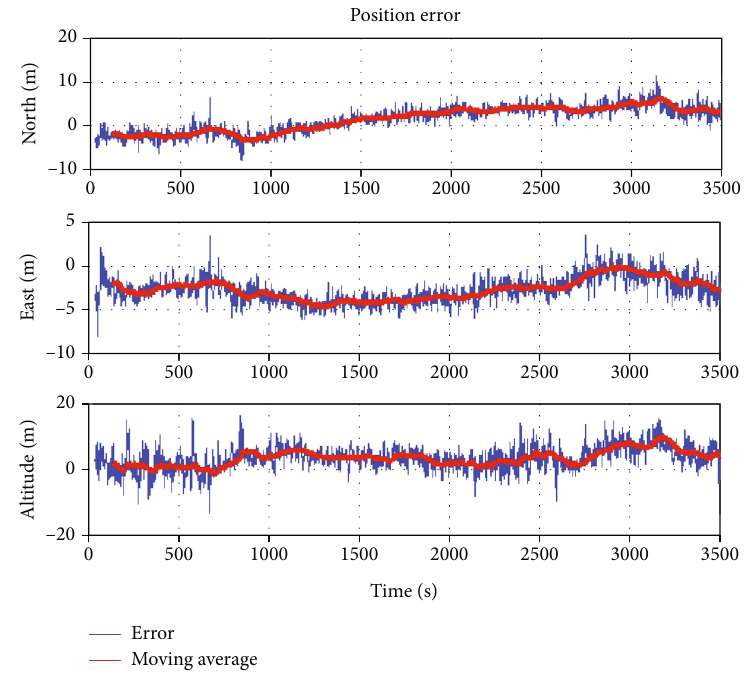
Figure 10: Position errors for ISS scenario.